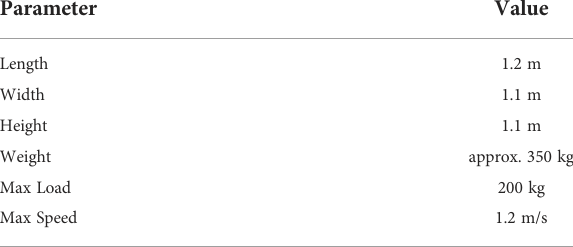
TABLE 1 Key parameters of